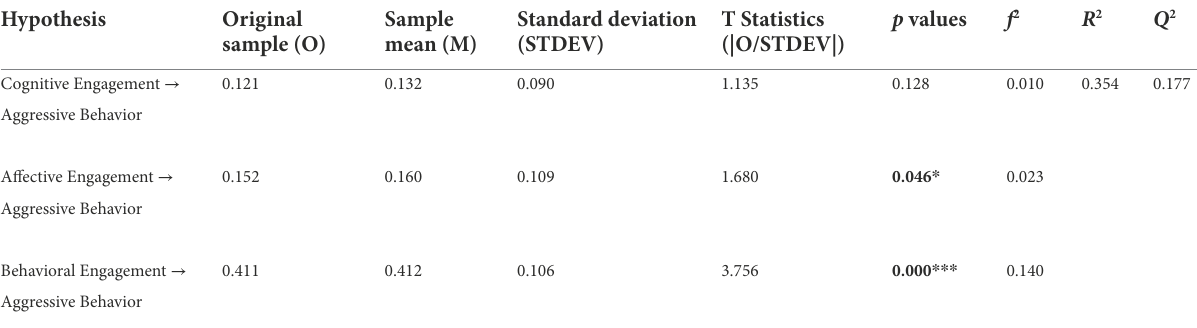
TABLE 5 Results of hypothesis testing.